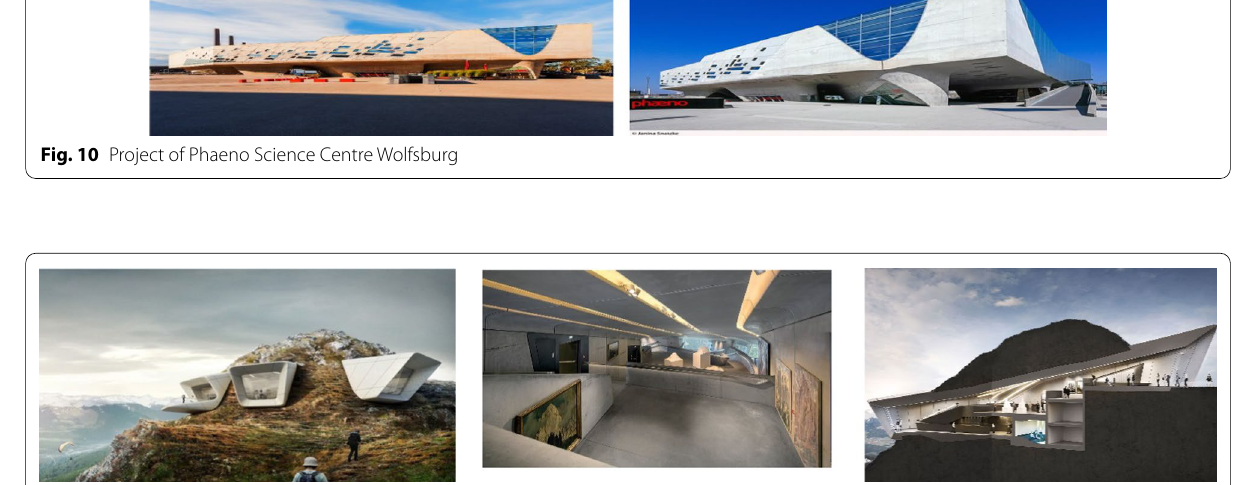
Fig. 11 Project of The Reinhold Messner